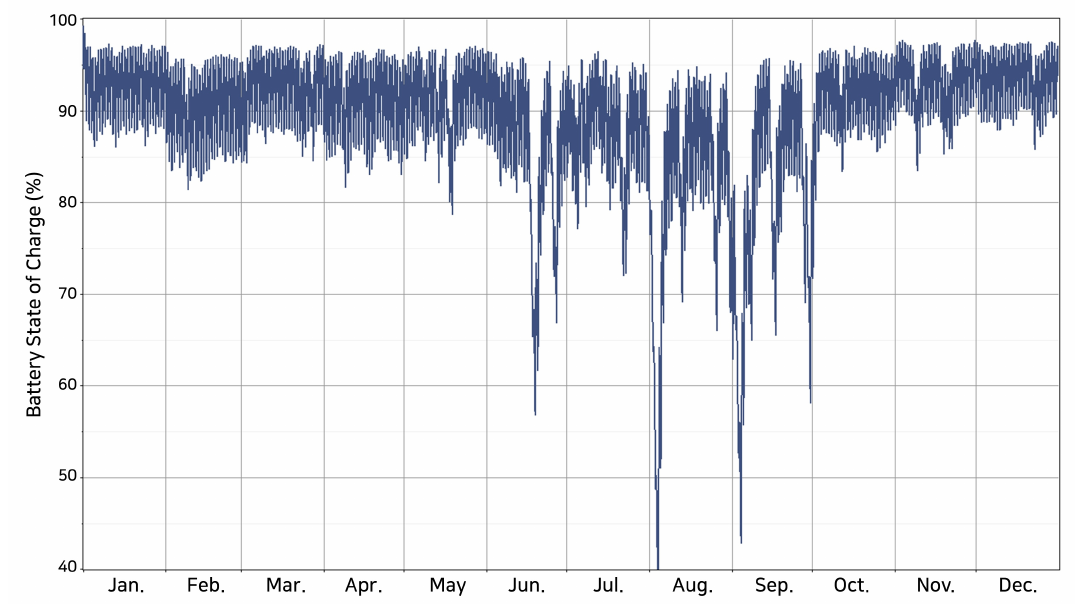
Figure 9. Monthly battery state of charge of the suggested configuration (created by the